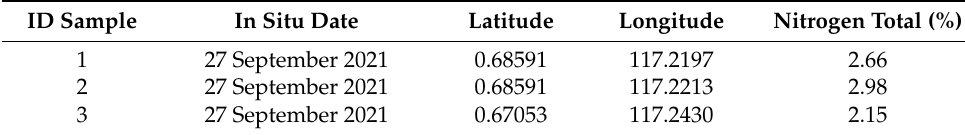
Table 3. Example of LSU nitrogen status data from an agronomy laboratory.